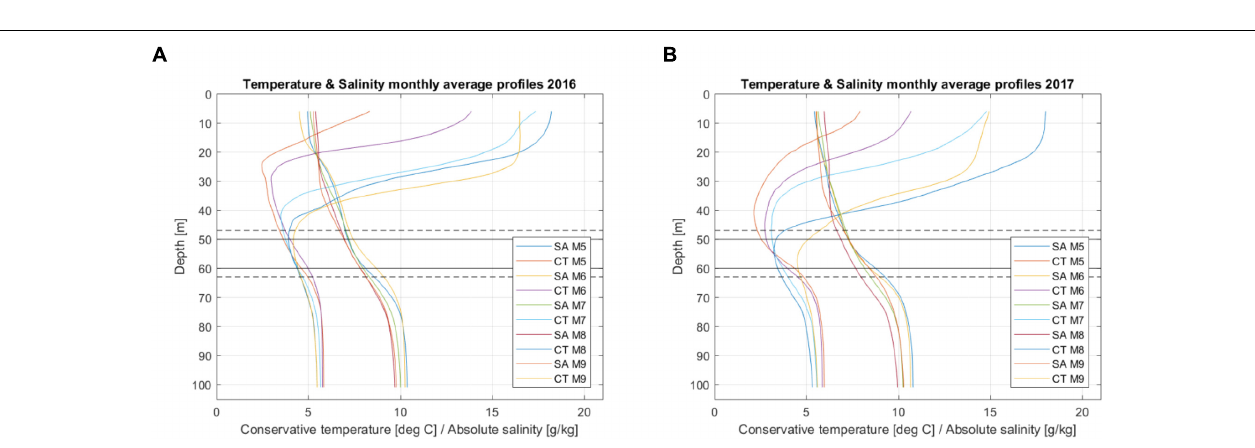
FIGURE 9 | Monthly average profiles of temperature (CT) and salinity (SA) for the period from May to September in 2016 (A) and 2017 (B) . Horizontal solid lines mark the depth interval of the stagnant layer. The dashed lines mark the depth interval of the extended layer used for the vertical diffusion estimates at the borders.